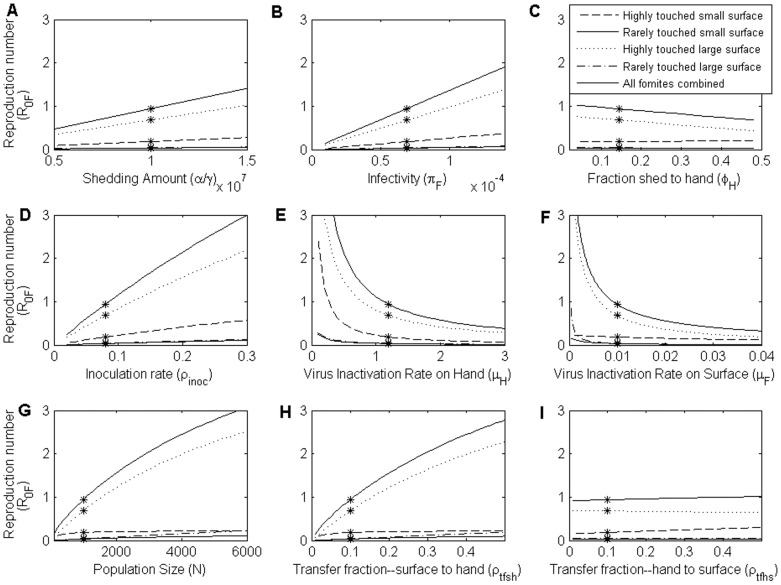
The total fomite transmission potentials.Total fomite transmission potential (Reproduction number) as a function of A) shedding amount α/γ, B) dose response of virus on mucosa πF, C) fraction of virus shed on hands φH, D) inoculation rate ρinoc, E) virus inactivation rate on hands µ
H, F) virus inactivation rate on fomites µ
F, G) population size N, H) fraction of pathogen transferred from surface to hands ρtfsh, and I) fraction of pathogen transferred from hands to surface ρtfhs, stratefied by fomite types. Stars on the lines are values of R0_F when the parameters take on values in Tables 1 and 2. Across all variation considered, the highly touched large surface fomite type has the highest transmission potential. The slope of each line, which can be interpreted as strength of each hypothetical control, is largest for the highly touched large surface fomite type.